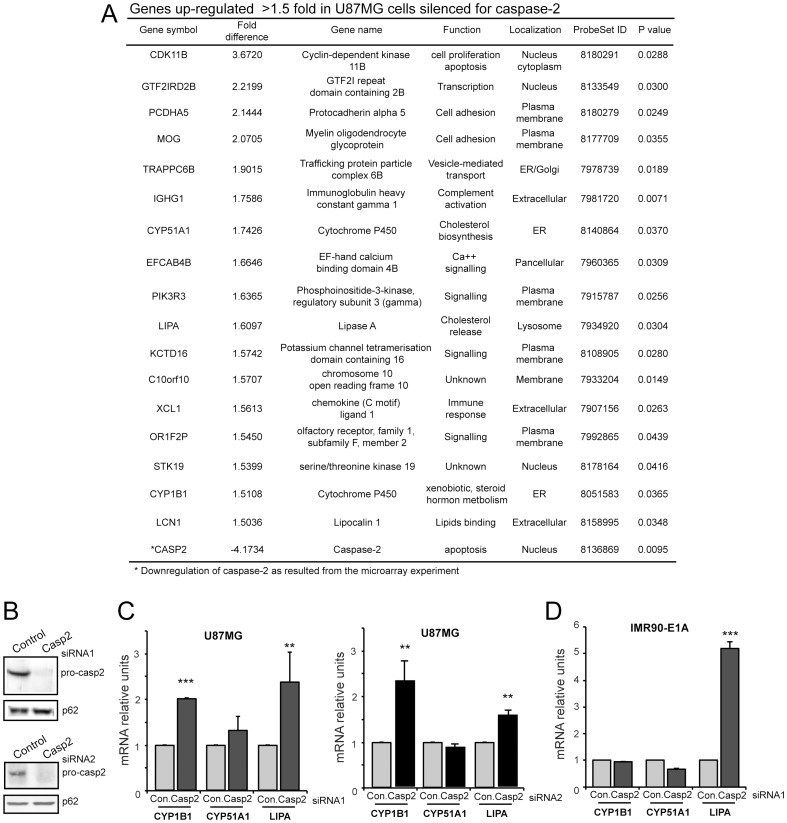
Transcriptomic variations in cells silenced for caspase-2.A. List of the top up-regulated genes (cut-off 1.5) in U87MG cells silenced for caspase-2 expression. B. Cellular lysates from U87MG cells transfected with the indicated siRNAs against caspase-2 or the relative control siRNAs were generated and after immunoblot were probed with an anti-caspase-2 antibody. P62, nucleoporin was used as loading control. C. mRNA expression levels of CYP1B1, CYP51A1 and LIPA were measured using qRT-PCR in U87MG cells transfected with the indicated siRNAs against caspase-2 or the relative control siRNAs. Data are presented as mean ± SD; n = 3. D. mRNA expression levels of CYP1B1, CYP51A1 and LIPA were measured using qRT-PCR in IMR90-E1A cells transfected with siRNA1 against caspase-2 or the control siRNA. Data are presented as mean ± SD; n = 3.